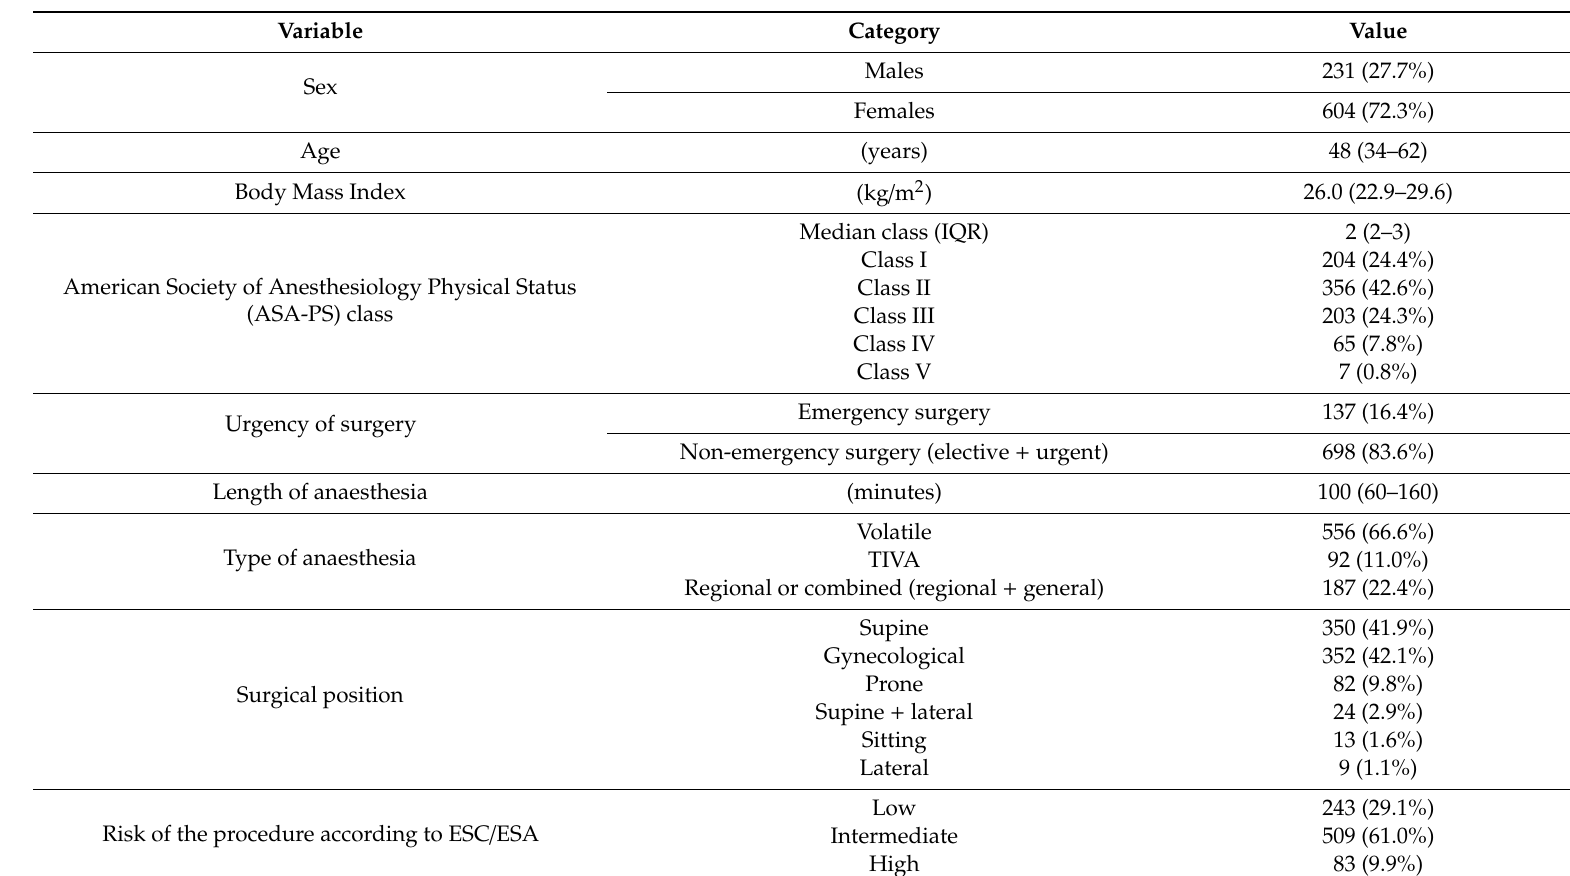
Table 1. Study group characteristics and procedure-related variables 1